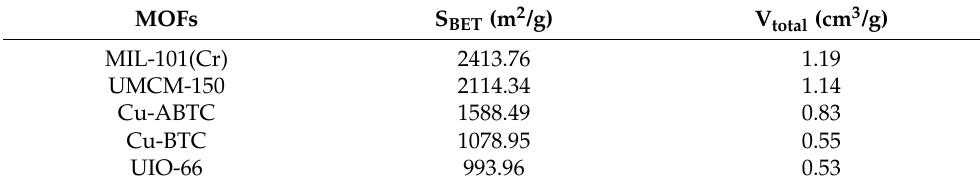
Figure 3. ( a ) Nitrogen adsorption-desorption isotherms and ( b ) NL-DFT pore-size distributions of the Cu-BTC, UMCM-150, MIL-101(Cr), UIO-66, and Cu-ABTC. Table 1. BET surface area and pore volumes of the five MOFs.